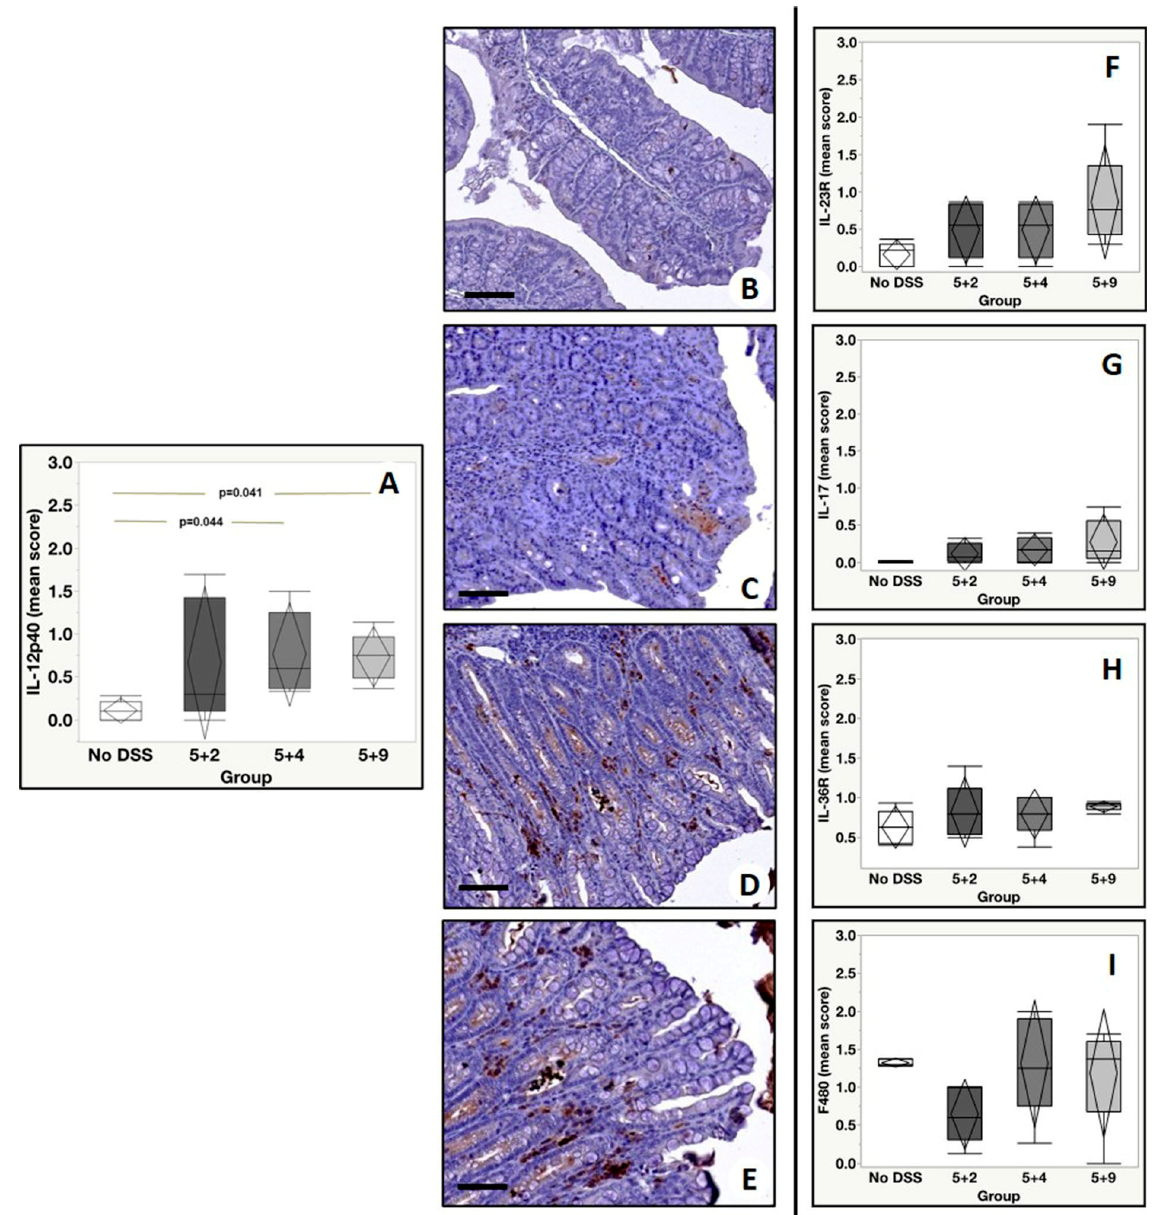
Figure 6. Immunohistochemical evaluation of the expression of IL-12p40, IL-23R, IL-17, IL-36R and F480. ( A ) Graph shows the expression of IL-12p40 among the experimental groups. ( B ) No/rare IL-12p40 positive cells are displayed. ( C ) Some IL-12p40 positive cells in a colon from 5 + 2 mouse. ( D , E ) Images show several IL-12p40 positive cells in bowels of 5 + 4 and 5 + 9 mice, respectively. ( F , G , H , I ) Graph show the expression of IL-23R, IL-17, IL-36R and F480 among the experimental groups. Scale bar represents 200 µm in each image.